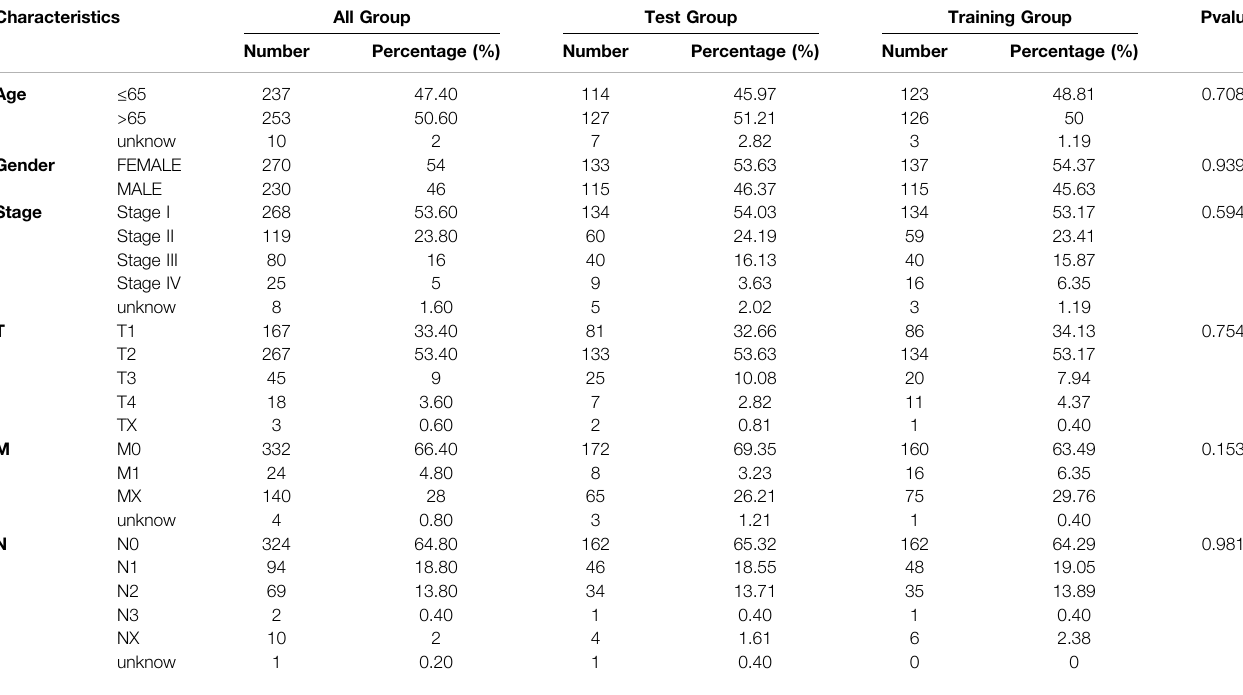
TABLE 1 | Patients ’ clinical characteristics.